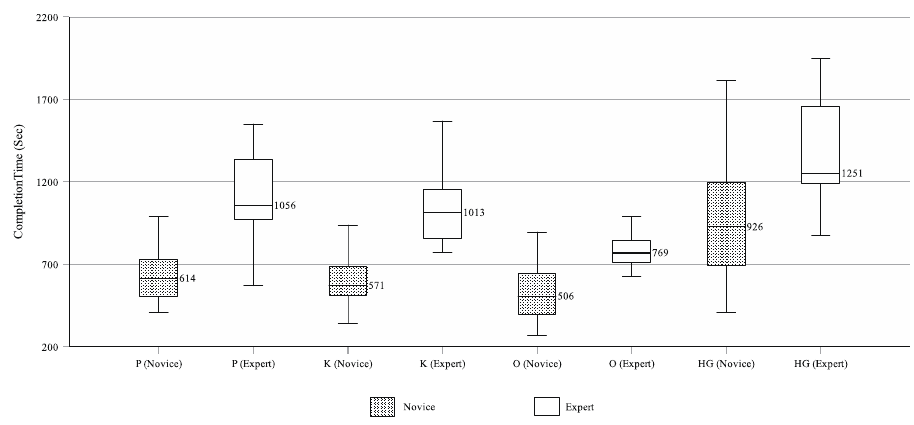
Figure 8. Distribution of task completion time (Sec) finishing with each approach for MCI. Table 2. Descriptive statistics of task completion time, accuracy, heart rate variation, the weight of workload, and the weighted score of the workload for each trial.